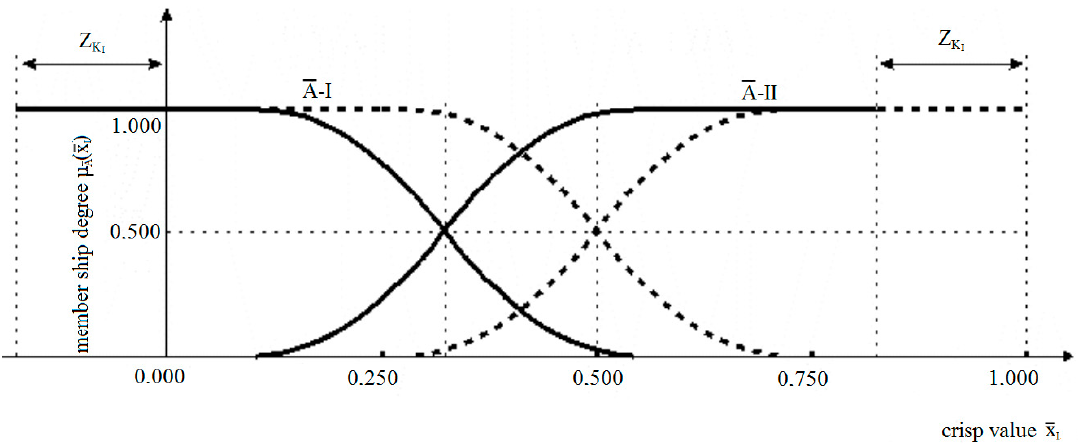
Figure 3. Modified membership functions of input sets A − i of the fuzzy model .